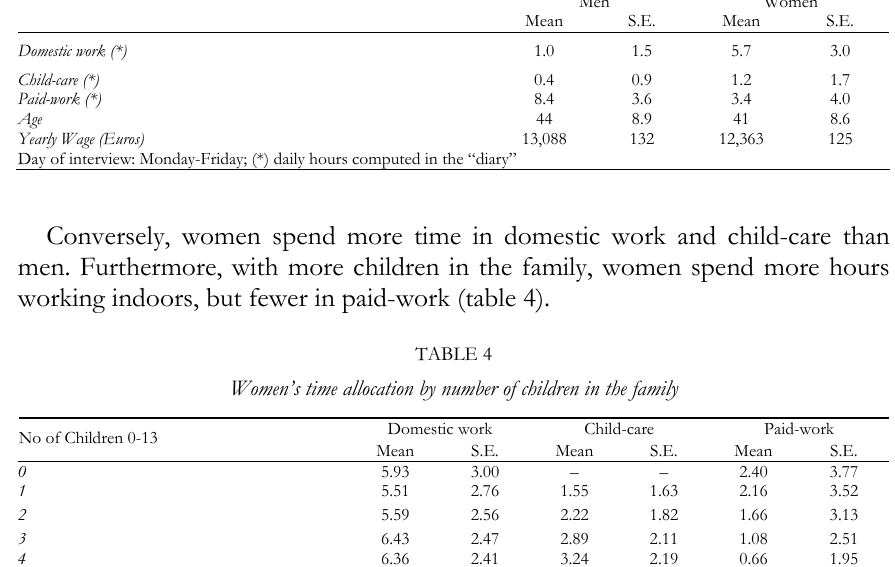
Men Women Mean S.E.